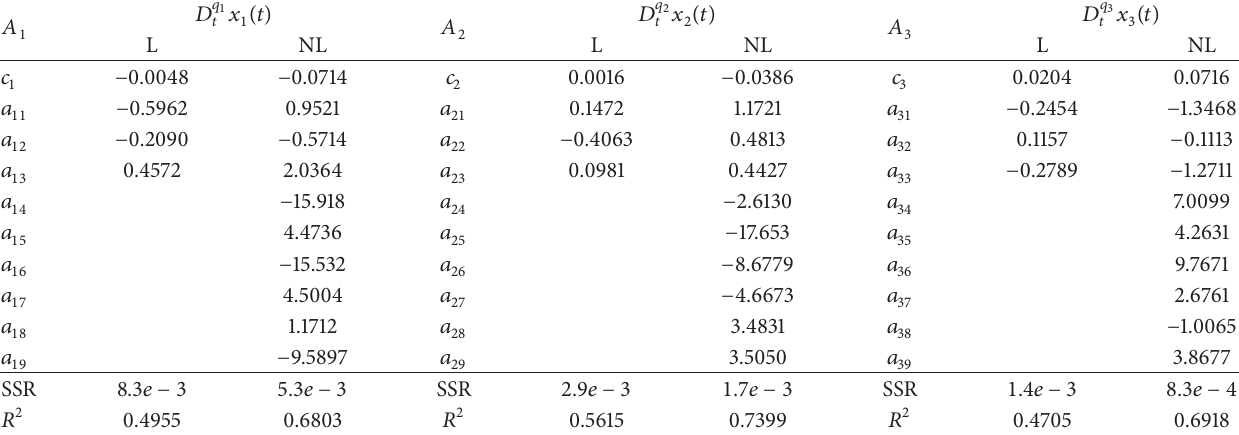
Table 3: The estimation results of parameters in model (12) with ℎ = 0.85